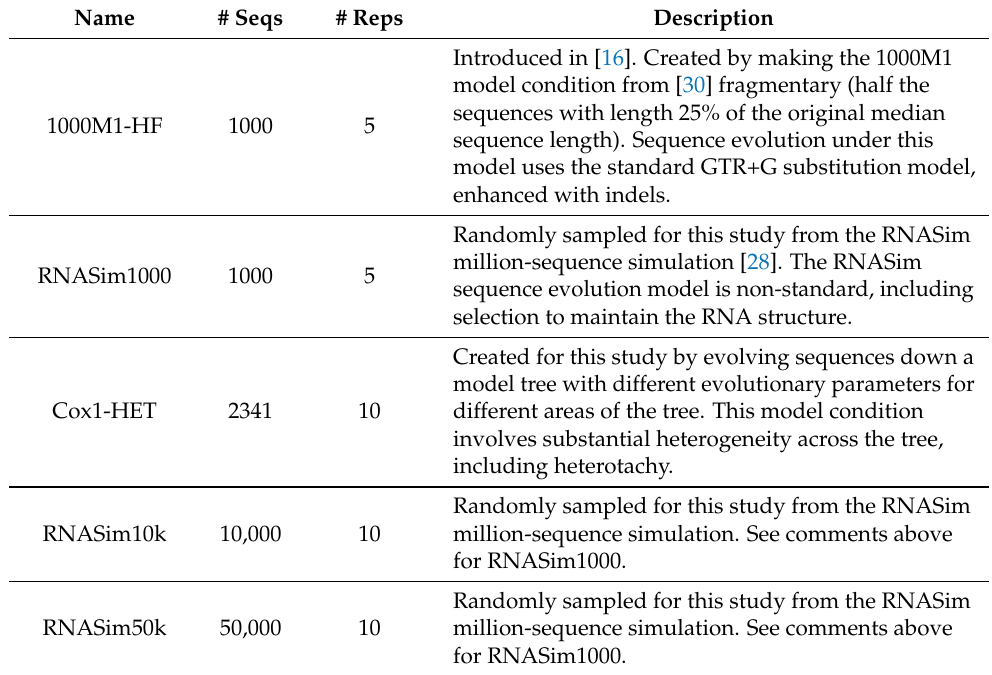
Table 2. Dataset